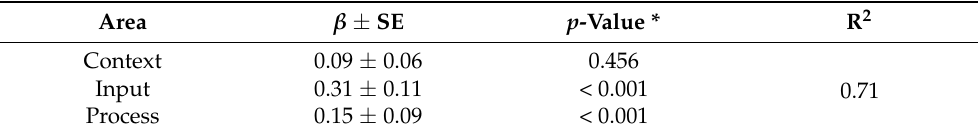
Table 6. Areas affecting satisfaction with the Follow-up Health Consultation